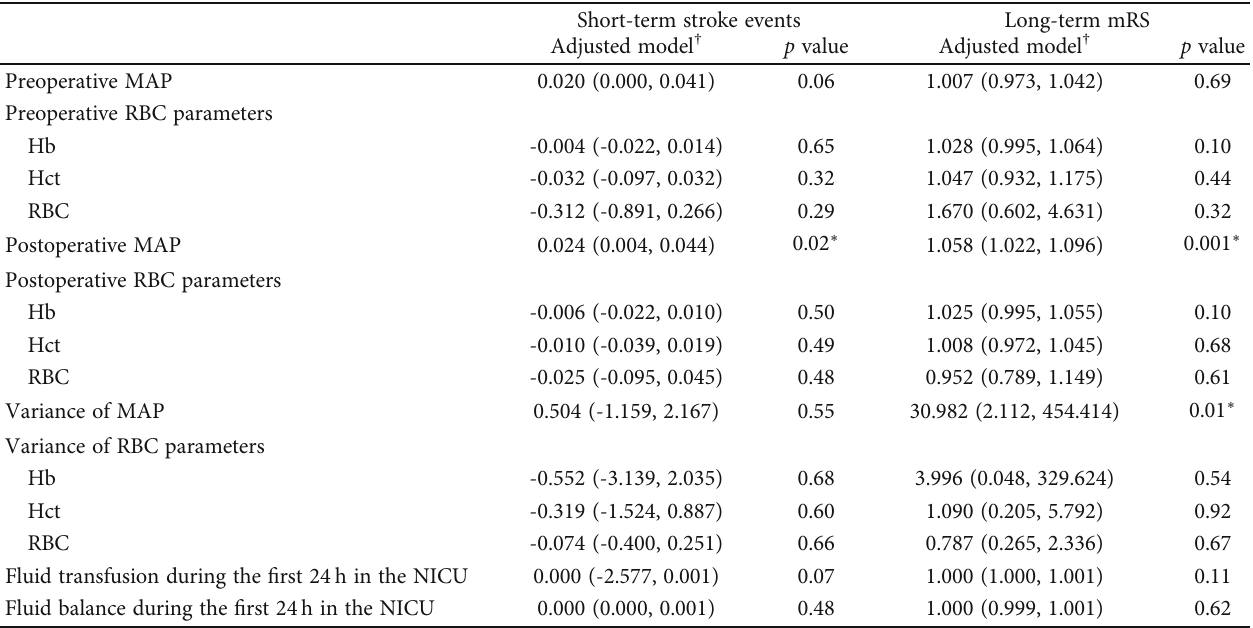
Table 3: Logistic regressions of perioperative factors associated with short-term stroke events and long-term